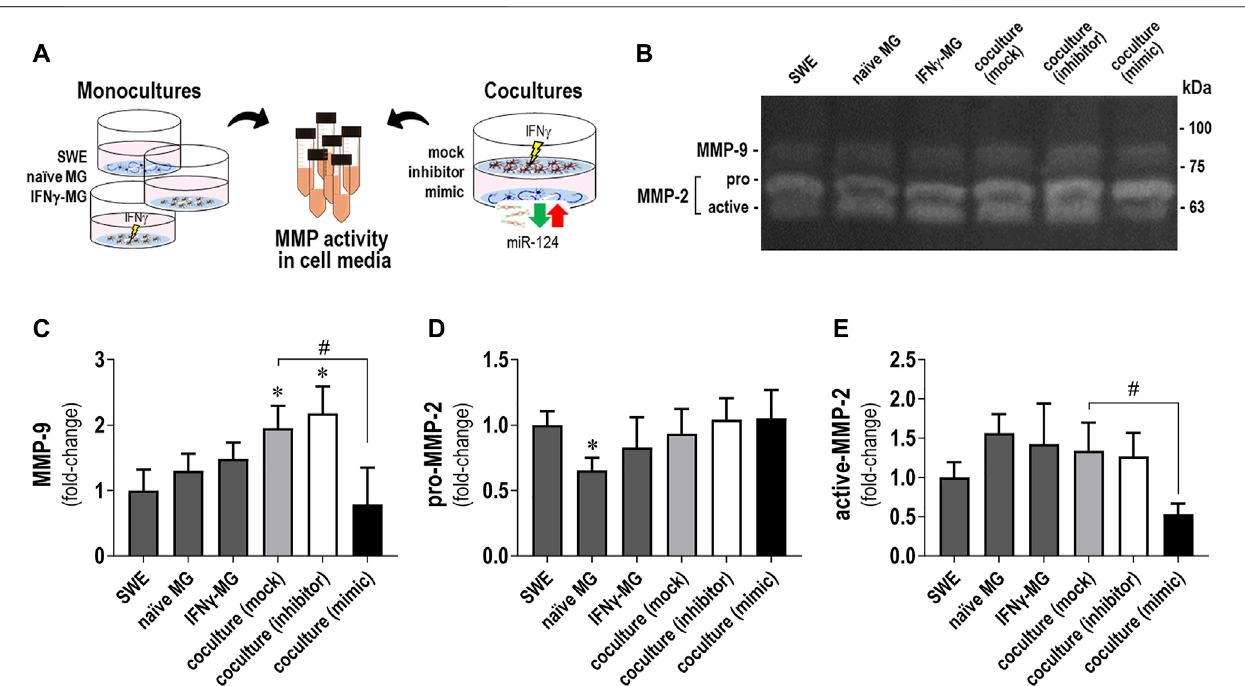
FIGURE6| ChangesinMMP-2andMMP-9activitiesbygelatinzymographyinsecretomesfromSWEandIFN γ -MGcells,ineithermonoculturesorcocultures,are determined by miR-124 expression levels. Cell media from the SWE and IFN γ -MG monocultures and cocultures were collected and analyzed for matrix metalloproteinase(MMP)gelatinaseactivities,asdescribedin MaterialsandMethods . (A) Schematicrepresentationoftheexperimentalconditions(ineithermonoculture or coculture) and cell media collection. (B) Representative images of the gelatin zymography assay showing the gelatinolytic bands of MMP-9 and MMP-2. Discrimination betweenthe pro- and active forms wasonly possible for MMP-2. (C) Quanti fi cation ofgelatinaseactivity MMP-9 (±80 – 90 kDa), (D) pro-MMP-2 (72 kDa), and (E) active-MMP-2 (62 kDa). Results are mean ± SD from at least three independent experiments. * p < 0.05 vs . SWE cell secretome, one-way ANOVA with the Bonferroni post hoc test; # p < 0.05 vs . coculture with the SWE mock, two-tailed Student ’ s t -test. SWE, human SH-SY5Y cells expressing the APP695 Swedish mutant protein; MG, CHME3 human microglia cells; IFN γ -MG, IFN γ -stimulated CHME3 human microglia cells.